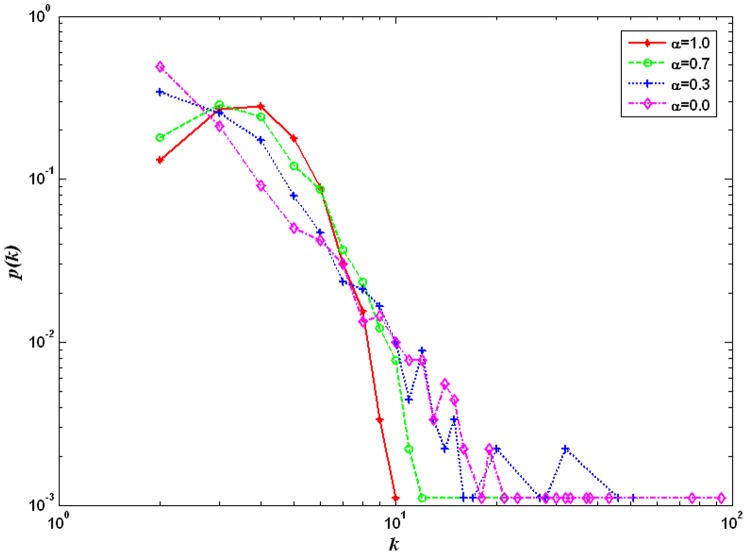
The degree distributions progressively changing from a random graph to a scale-free network.The network size is 900. The parameter α is 1.0, 0.7, 0.3 and 0.0 respectively. α = 1 corresponds to a random graph. The node degree of the network satisfies a Poisson distribution. With the decrease of α, the node degree of the network gradually changes to a power-law distribution. α = 0 corresponds to a scale-free network. The degree distribution of the network has an obvious fat-tail phenomenon.